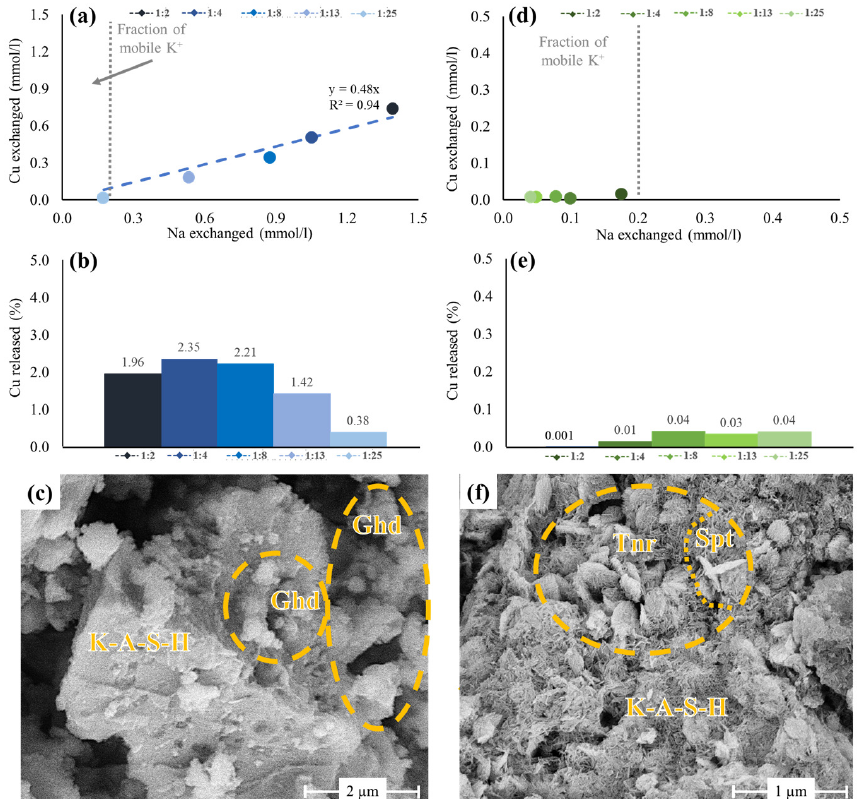
Figure 4. Compilation of results obtained from the ion exchange experiments. ( a , d ) Cross-plots of the Cu 2+ and Na + concentrations showing stoichiometric ion exchange in the Cu:GP series and no ion exchange in the Cu:GP pH series. Note the different scale in ( a , d ); ( b , e ) Fraction of Cu 2+ liberated into the solutions upon ion exchange in the Cu:GP and Cu:GP pH series. Note the small amounts of ‘mobile’ K + released back to the solutions and the different scale in ( b , e ); ( c , f ) The SE images of the Na + -exchanged samples Cu:GP-1:2 and Cu:GP pH -1:2 reveal no microstructural changes after the ion exchange reaction. Ghd—gerhardtite; Spt—spertiniite; Tnr—tenorite.